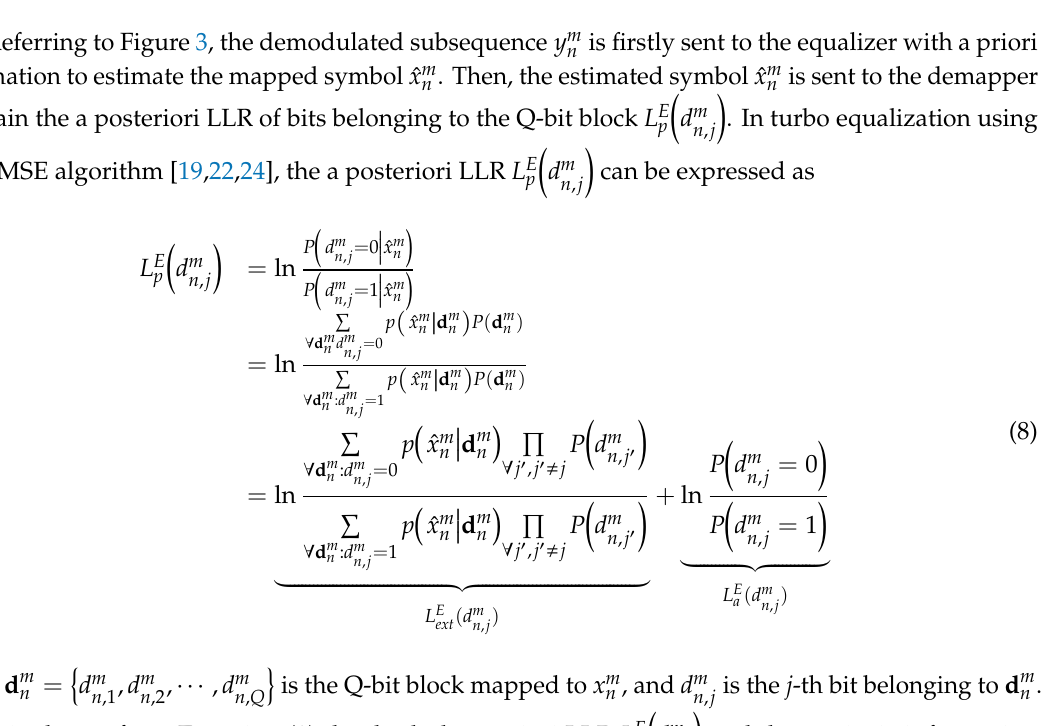
Figure 3. Block diagram for turbo equalization.